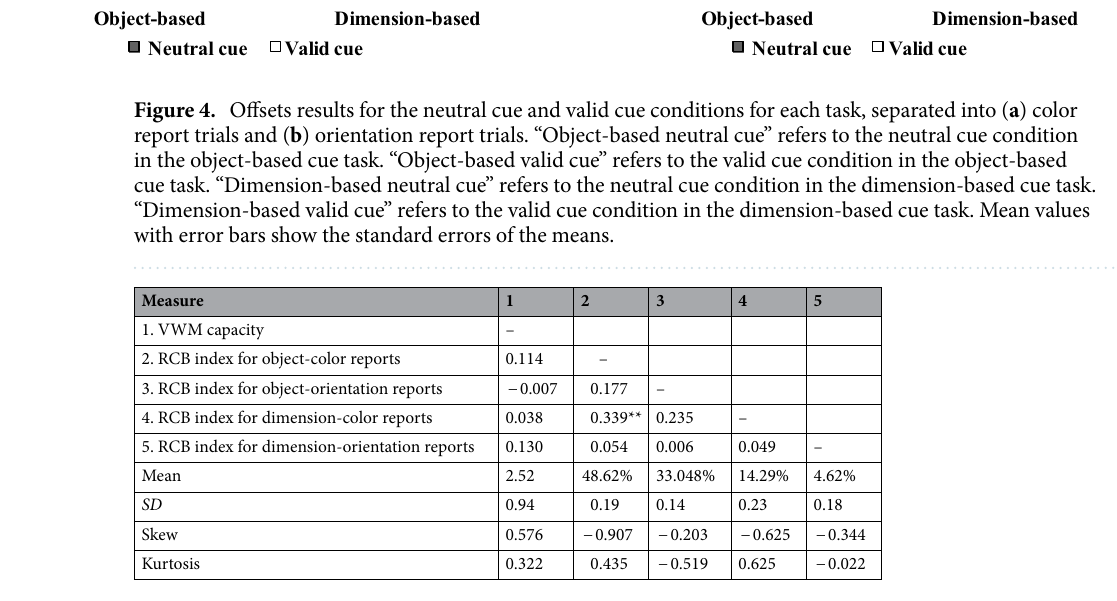
Table 1. Descriptive statistics and correlations for VWM capacity and the RCB index for each condition. “Object-color reports” refers to the color report trials in the object-based cue task. “Object-orientation reports” refers to the orientation report trials in the object-based cue task. “Dimension-color reports” refers to the color report trials in the dimension-based cue task. “Dimension-orientation reports” refers to the orientation report trials in the dimension-based cue task. N = 68, **p <